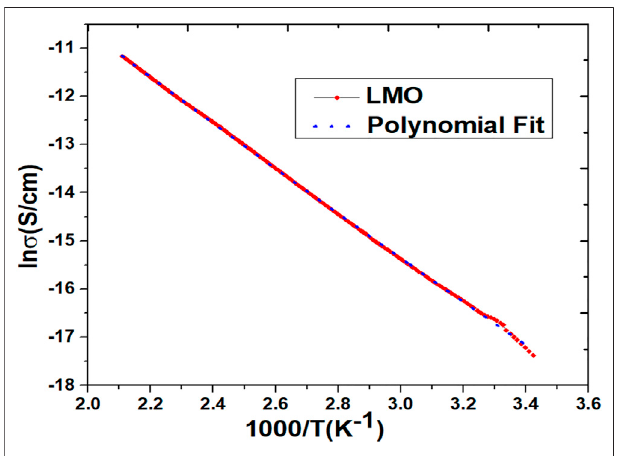
FIGURE 4 | FTIR spectrum of the synthesized LMO sample.